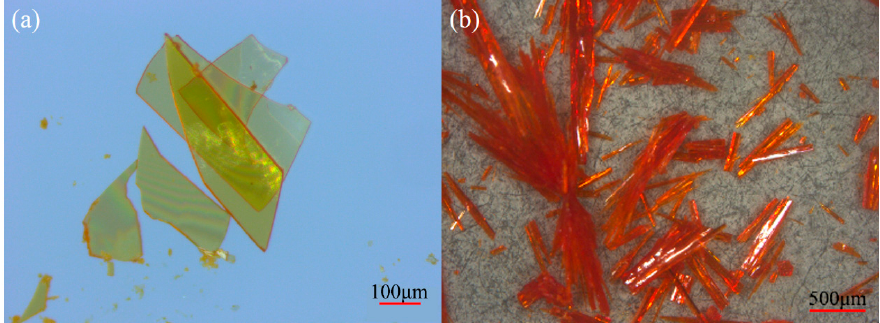
Crystals 2020 , 10 , x FOR PEER REVIEW Figure 1. Optical microscope images of ( a ) plate-like 6cazpy crystals and ( b ) needle-like complex-I crystals.